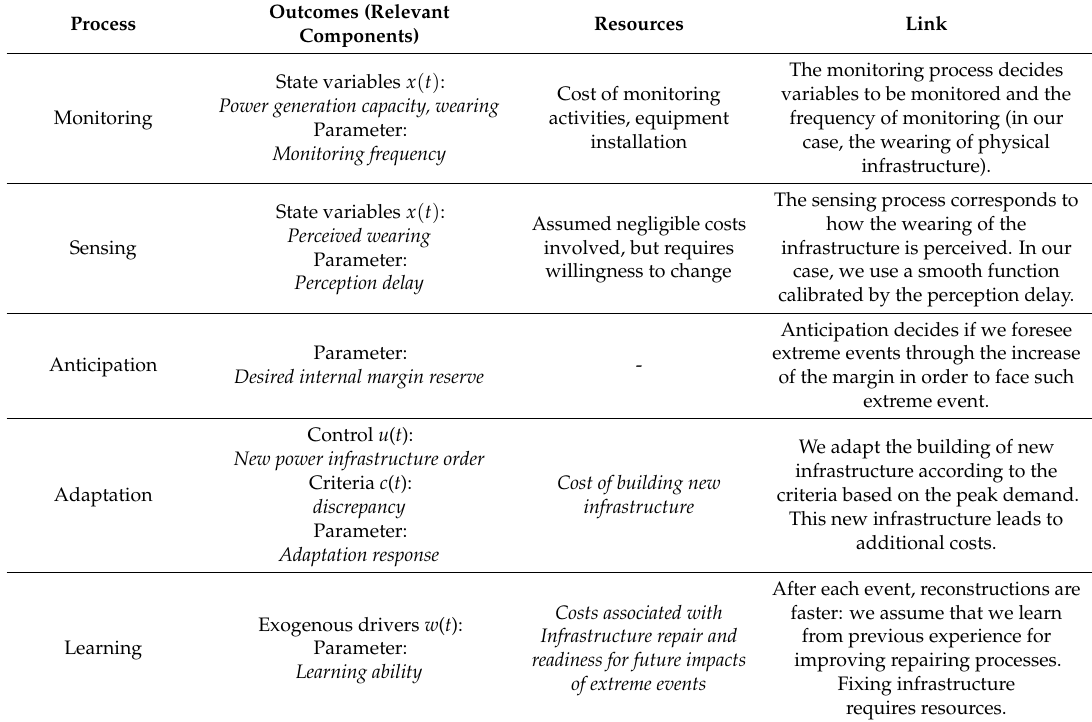
Table 2. Main dynamical connections between outcomes, processes and